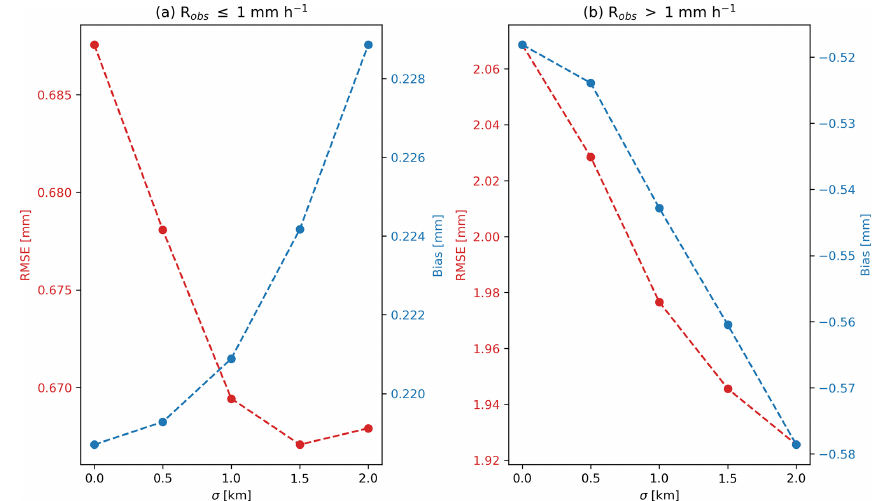
Figure D1. Hourly RMSE and linear bias (average of estimated versus observed value) as a function of the value of σ (a) for low intensities and (b) for higher